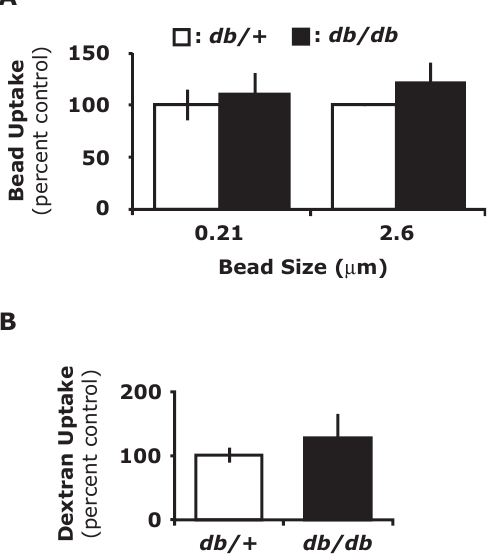
Figure 2. Phagocytosis and fluid-phase endocytosis are not increased in PerM W s from db/db mice. A , Db / + and db/db mice were IP administered 0.21 or 2.6 m m latex microspheres (beads) at 5 6 10 9 or 5 6 10 7 beads/ml, respectively. Following a 4 h in vivo incubation period, PerM W s were collected and microsphere uptake was measured by flow cytometry. B, Db / + and db/db mice were IP administered 0.25 mg/ml FITC-dextran. Following a 4 h in vivo incubation period, PerM W s were collected and dextran uptake was measured by flow cytometry. Results for A and B represent the average of three independent experi- ments 6 SEM.